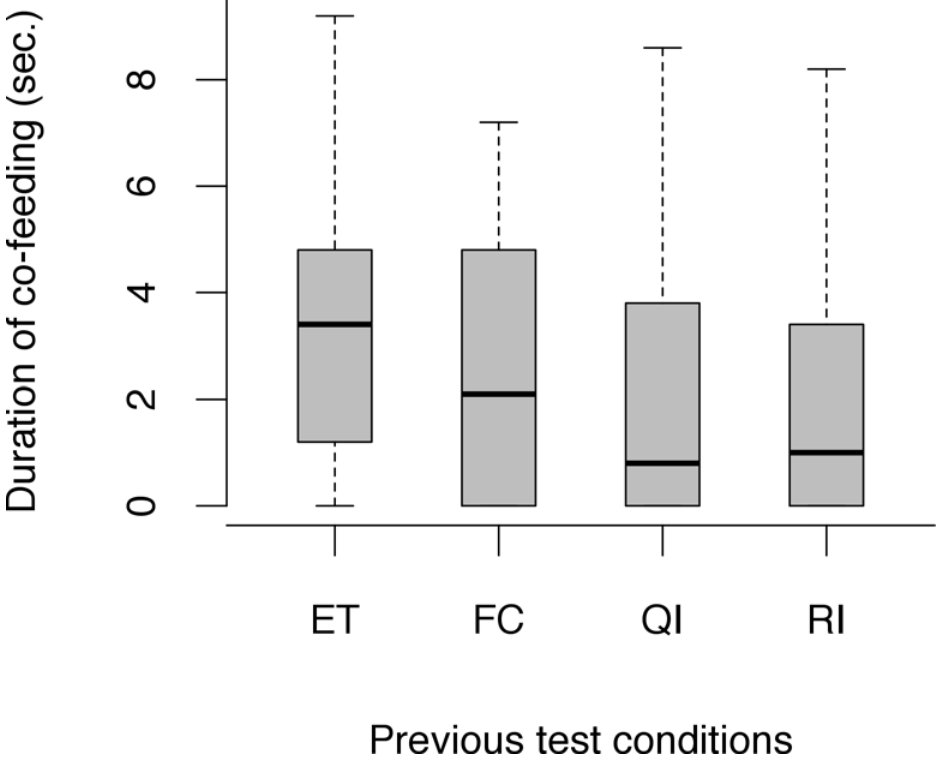
Fig 5. Duration of co-feeding following each social test condition ( N = 30). Black bars indicate median values, whiskers display upper and lower hinge, and boxes show the interquartile range.